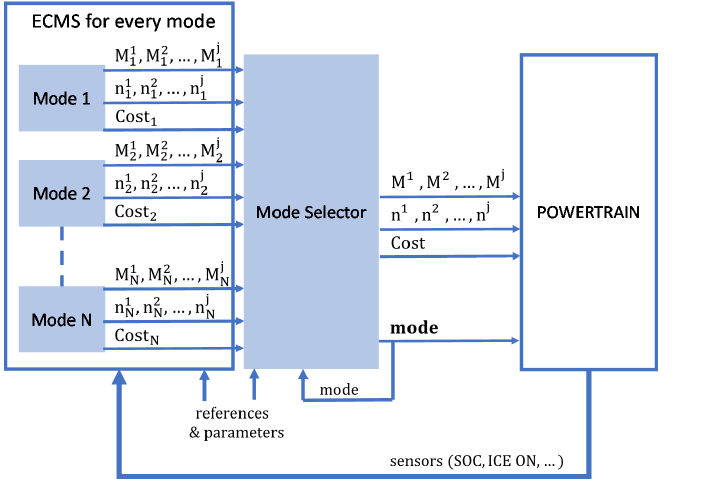
Figure 10. Scheme of the extension of the ECMS to integrate several ( N ) modes and the corresponding torque and speed demands of the j engines and electric